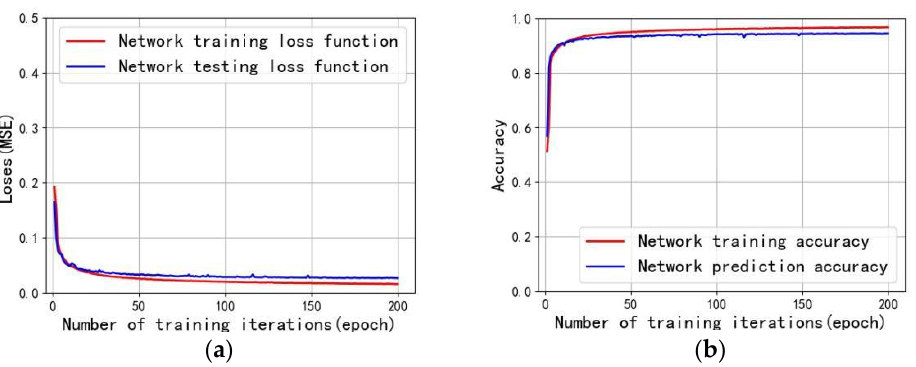
Figure 9. Evaluation of stability of model fitting curve. ( a ) Plot of training iterations vs. loss function; ( b ) plot of training iterations vs. accuracy.